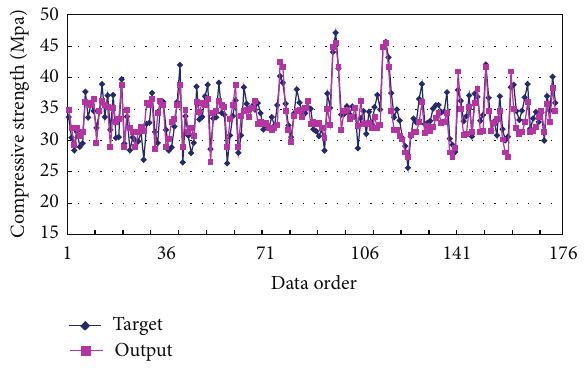
Figure 4: Results of training with 176 data sets.